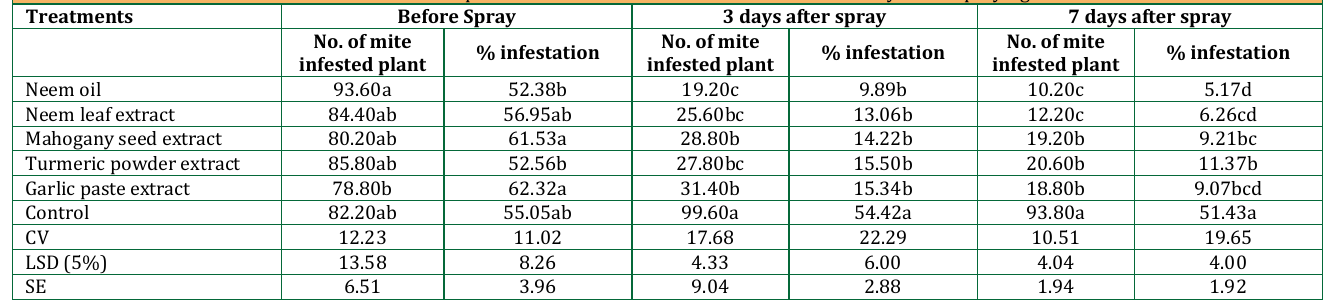
Table 3: Effects of plant extracts on survival of mite infestation at days after spraying Treatments Before Spray 3 days after spray 7 days after spray No. of mite % infested plant